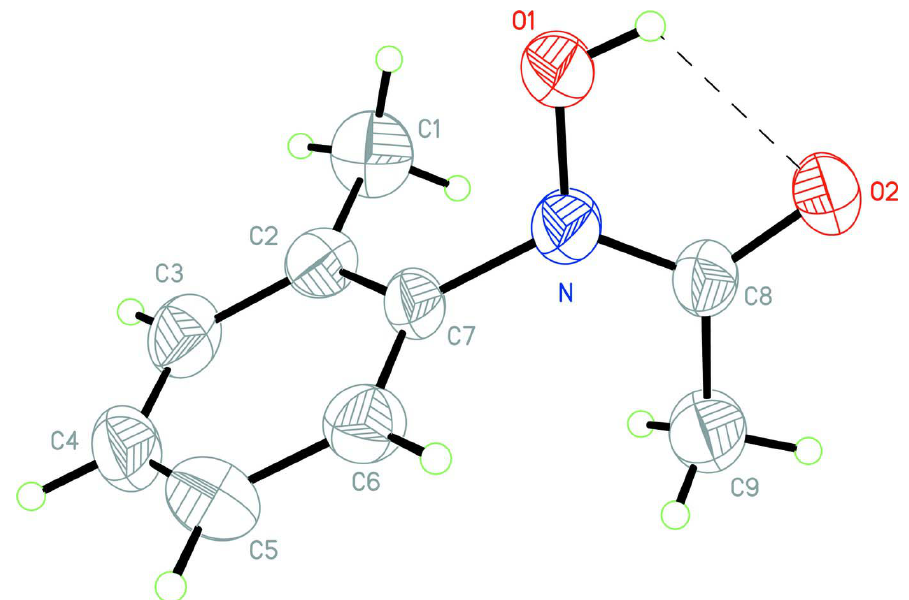
Figure 1 The molecular structure of the title molecule, with the atom-numbering scheme. Displacement ellipsoids are drawn at the 50% probability level.